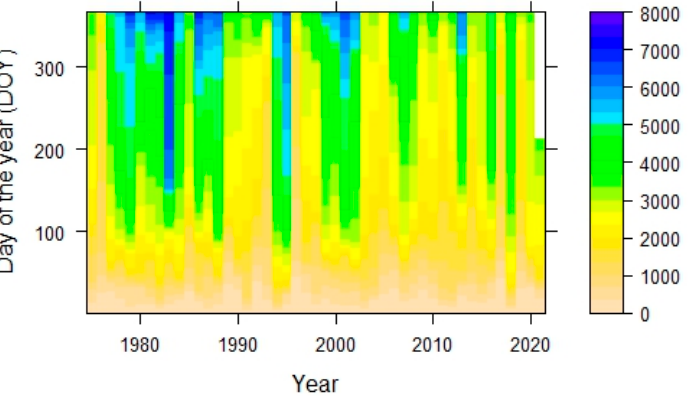
Figure 4. Cumulative yearly discharge in Perl plotted against the days (DOY, y -axis) of the respective year ( x -axis). Data refer to the 1975 to July 2021 data series.